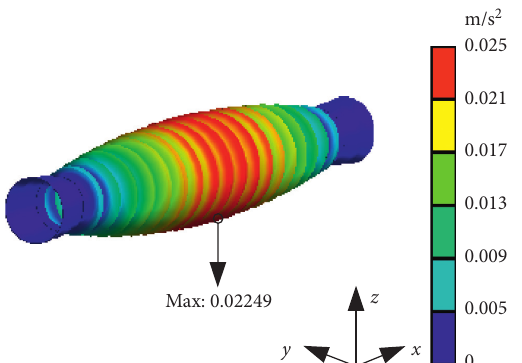
Figure 14: The acceleration of the busbar shell at 2900Hz in ANSYS Workbench.